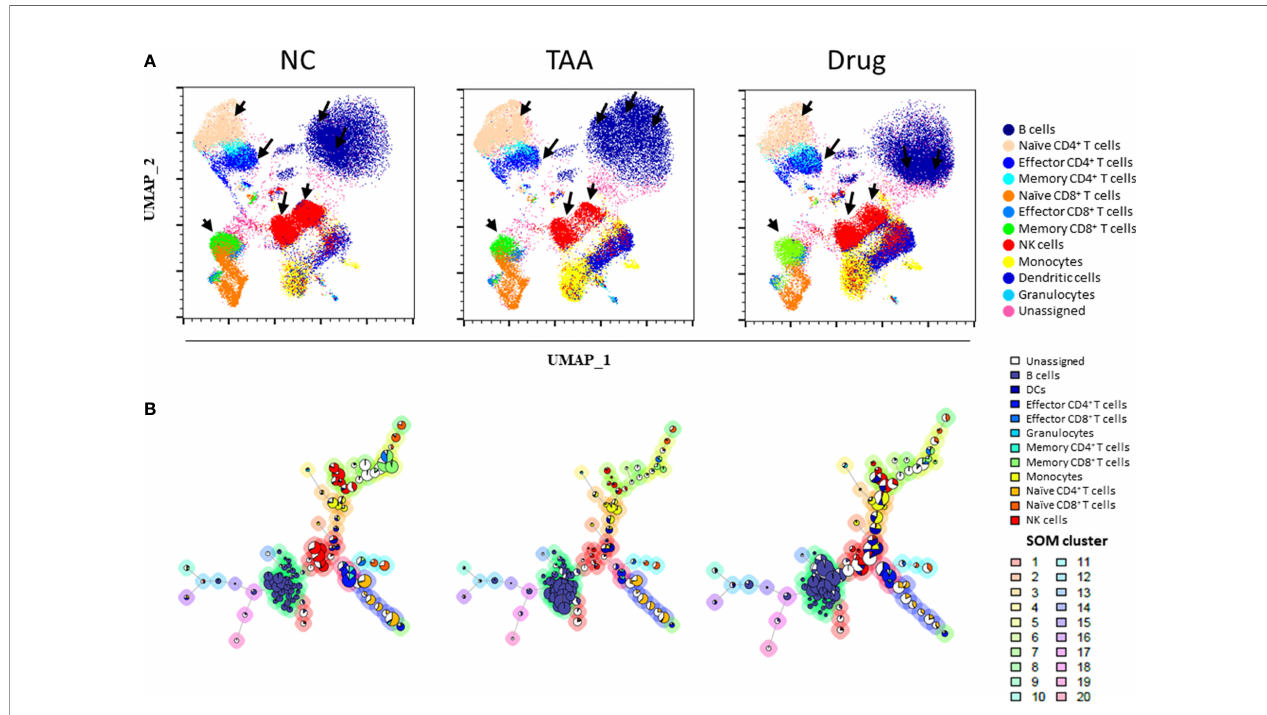
FIGURE 2 | Uniform manifold approximation and projection (UMAP) visualization of (A) the immune leukocytes population density between NC, TAA, and Drug groups. The arrows indicate the UMAP manually gated clusters with signi fi cant differences between the NC, TAA, and Drug groups. (B) Population pie graph of the NC, TAA, and Drug groups on FlowSOM minimum spanning trees (MSTs). The pie chart representation of population abundance aggregated with NC, TAA, and Drug